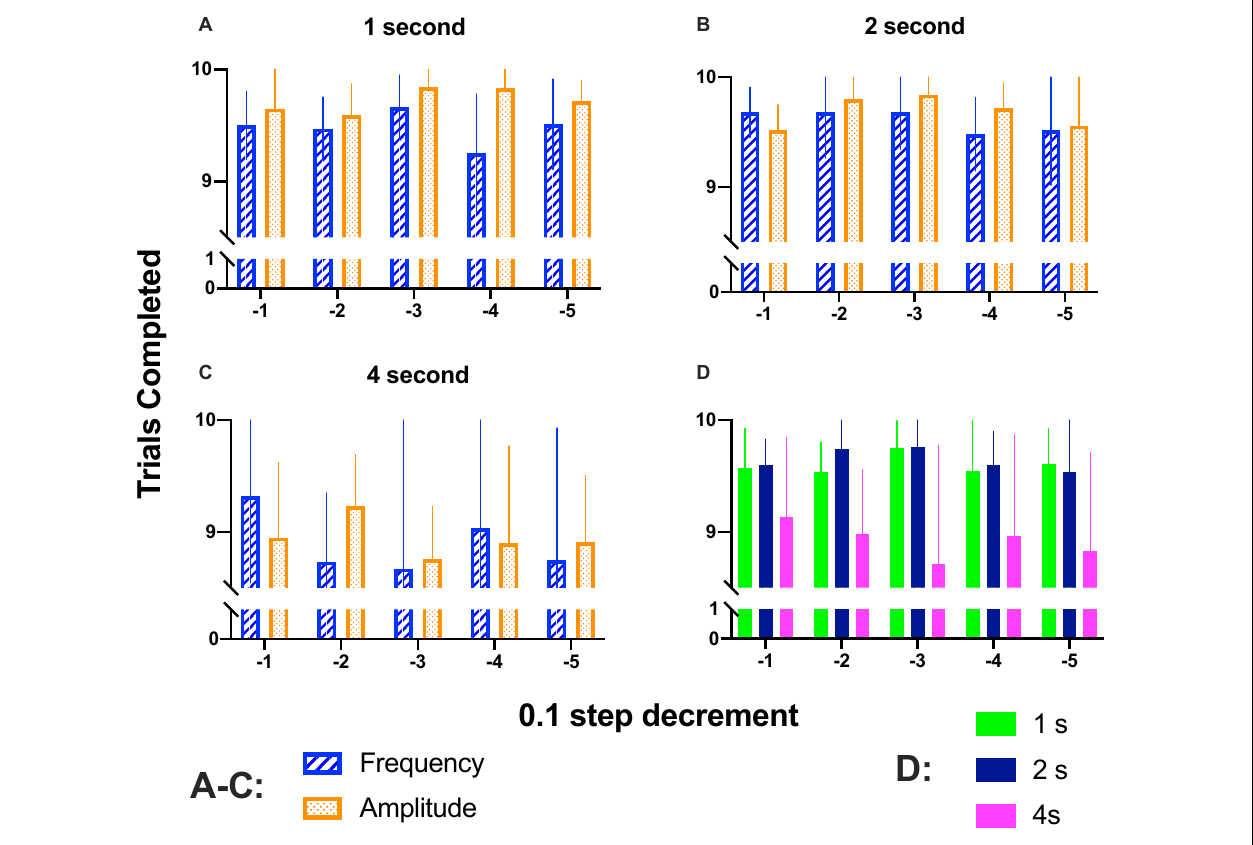
depicted in Figures 3A , 5A of TA while TA plots showed rightward shifts as the price increased. DIs showed an inverse relation: as the price increased, we observed a trend toward a leftward shift instead of the rightward shift of TA. Rat LE11 showed a similar trend, but the DIs of the other rats showed minimal effects of the price increments ( Figure 8B ).